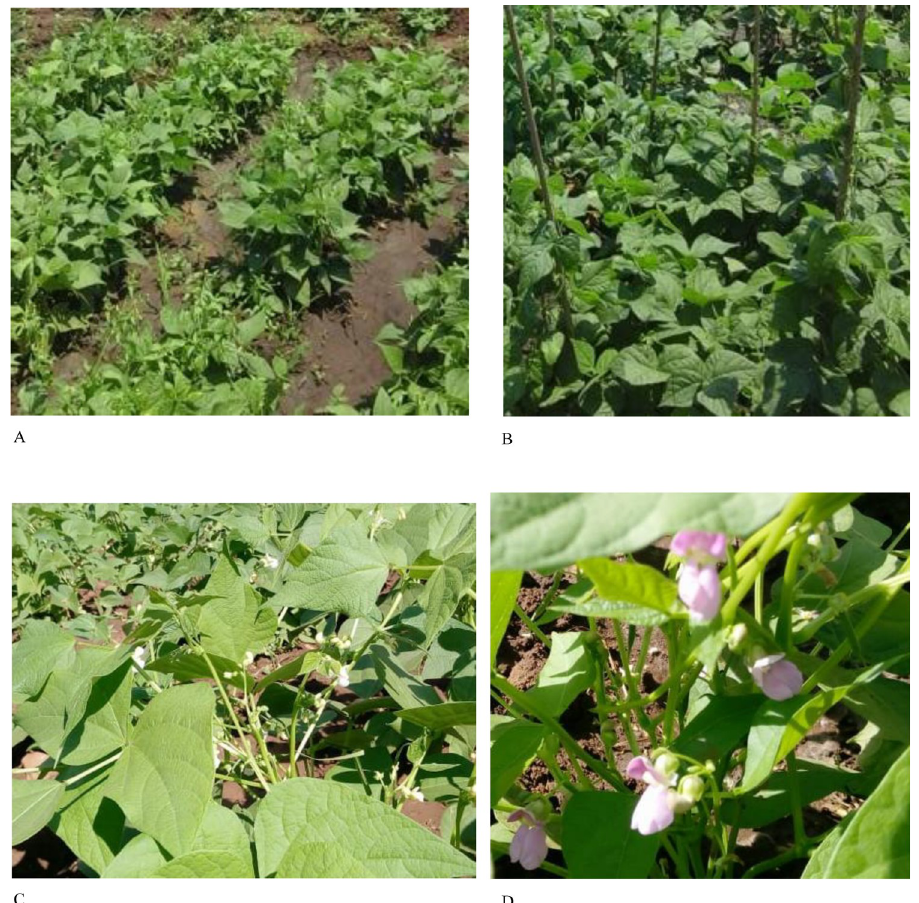
Fig 1. Growth type and flower colour among assessed common bean genotypes. Note: A–determinate growth type (genotype SUGAR 131), B–indeterminate growth type (MW3928), C–white flower (MW3969) and D–purple flower colour